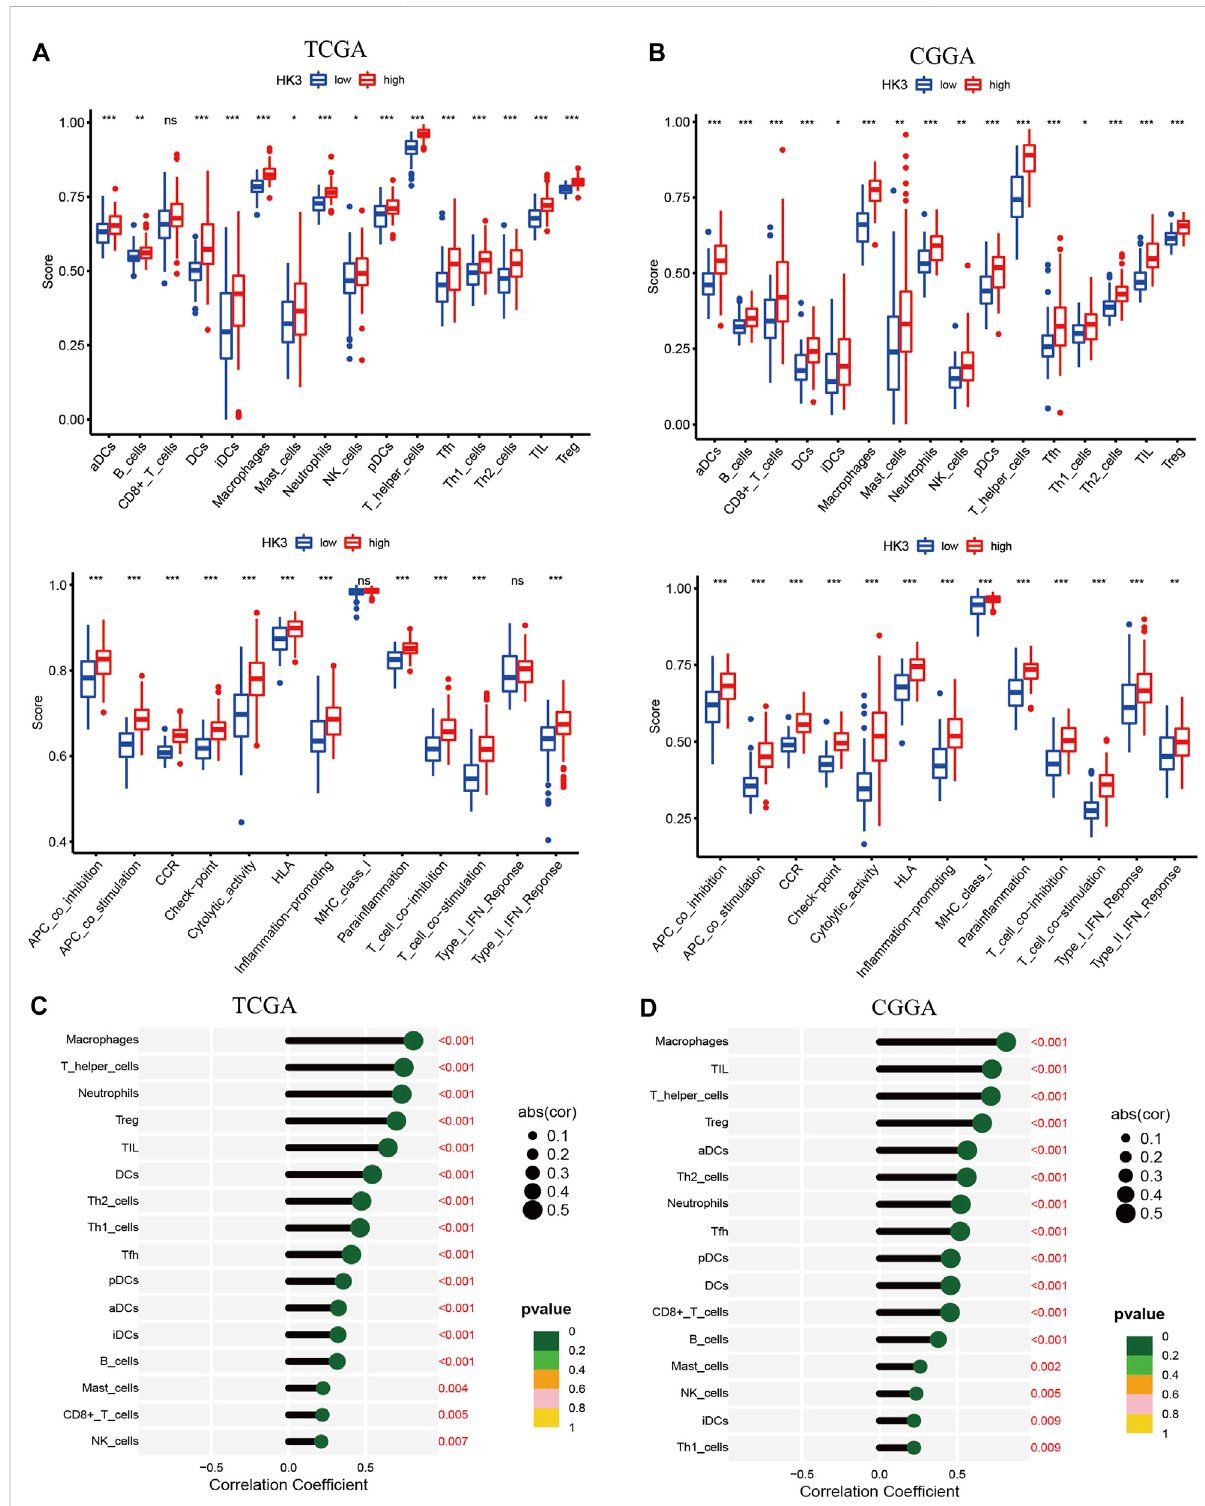
FIGURE 5 Relationship between HK3 and immune activity in GBM. Enrichment scores of 16 immune cells and 13 immune-related pathways between high-andlowHK3expressiongroupsintheTCGA (A) andCGGA (B) cohorts.Correlation betweenHK3expressionandimmunecellin fi ltrationinthe TCGA (C) and CGGA (D) cohorts. (* p < .05; ** p < .01; *** p <